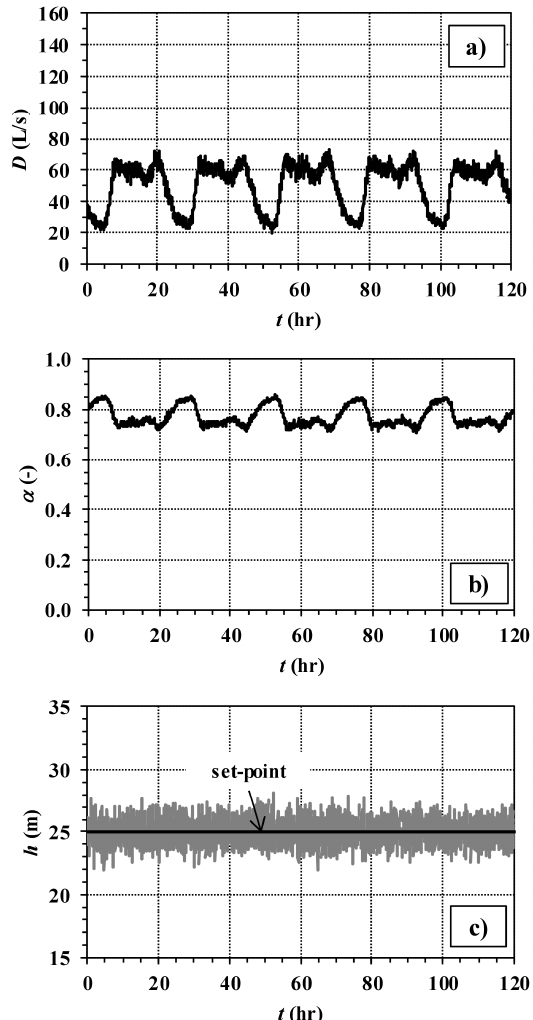
Figure 6. RTC of control valve through LCb under conditions of modified demand. In the five days of network operation, trends of total network demand ( a ), device setting ( b ) and controlled pressure head ( c ).